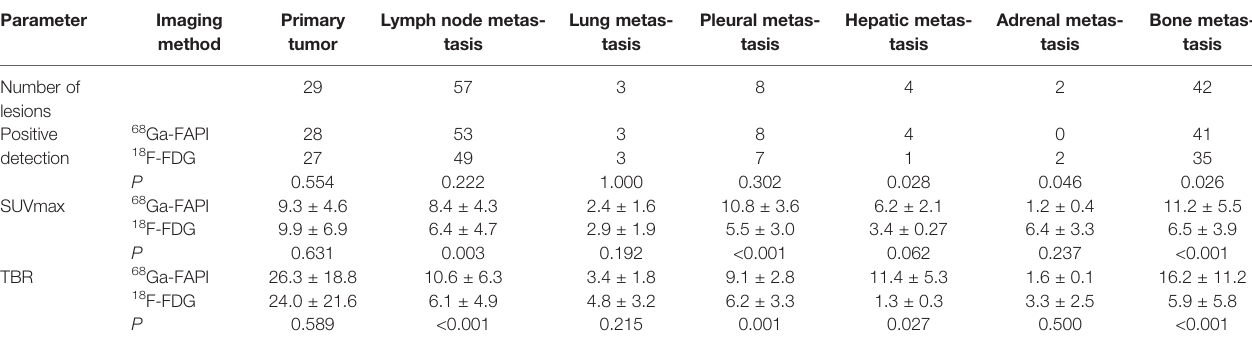
TABLE 2 | Comparison of 68 Ga-FAPI and 18 F-FDG PET/CT semi-quantitative imaging parameters. Parameter